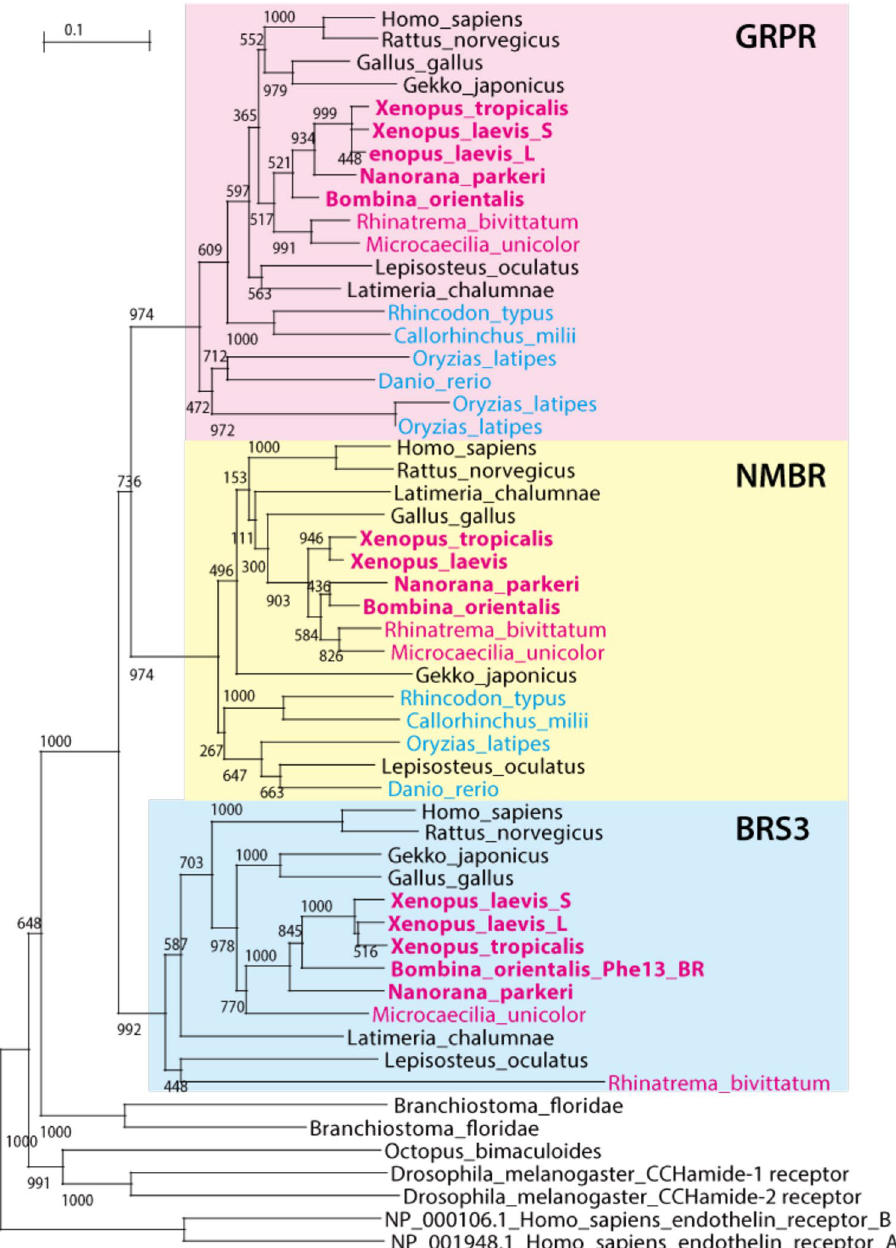
Figure 3. Molecular phylogeny of gastrin-releasing peptide-preferring receptor (GRPR)/neuromedin B-preferring receptor (NMB)/bombesin receptor subtype-3 (BRS-3). The GRPR/NMBR/BRS-3 family gene diverged into GRPR (pink box), NMBR (yellow box) and BRS-3 (blue box) in the ancestor of vertebrates. All the three receptors are widely conserved among vertebrates including frogs, although BRS-3 genes are not found in teleost and cartilaginous fish. Species name in magenta: amphibians; bold: frogs; cyan: cartilaginous fish. IDs for the protein sequences used in this analysis are shown in Supplementary Table